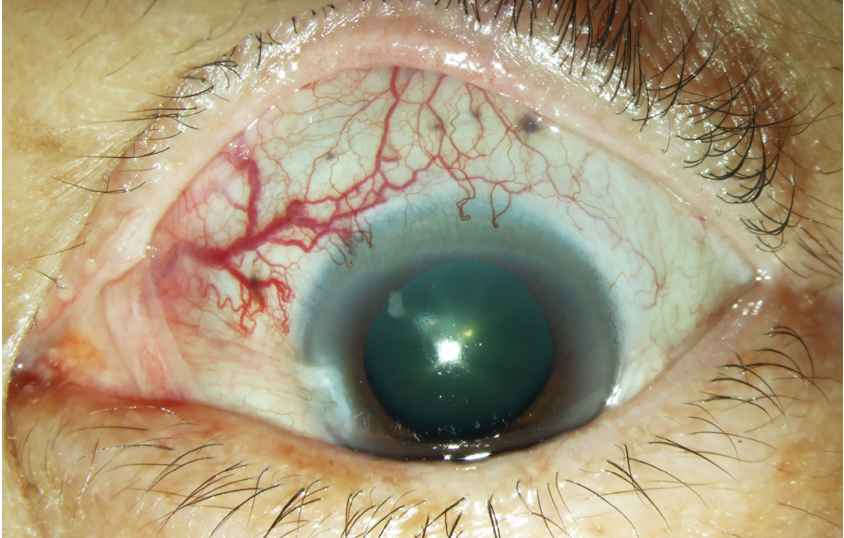
Figure 1. External photograph of the left eye. Prominent dilated episcleral vessels in the superonasal region of the left eye.